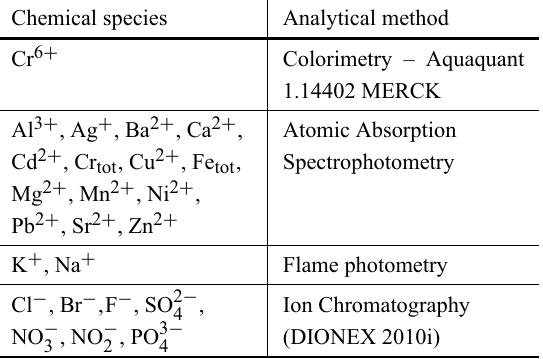
Analytical methods used during sampling events from 1994 to 1999.